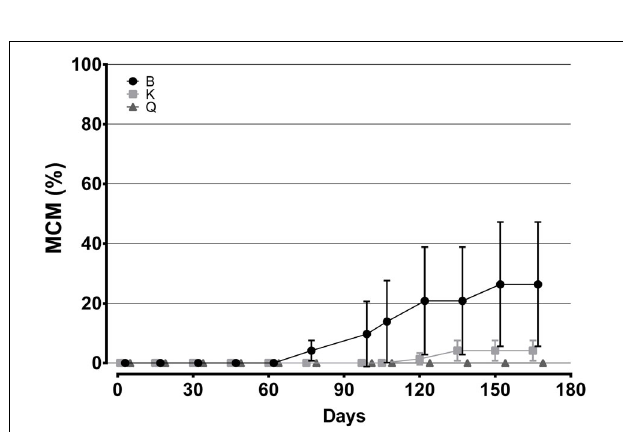
FIGURE 5 | Variation in mean cumulative mortality (MCM,%) for cuttlefish reared in different tank types during the growth stage. Data are presented in offset. Bars represent standard deviation.